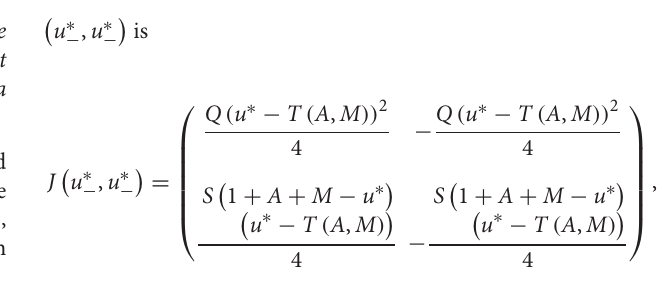
FIGURE 6 | Phase plane of system (4) for A 0.1, M 0.1 and Q 0.363 for varying S . The equilibria (0,0), (1,0) and P 2 are always saddles. The brown (red) = = − = curve represents the predator (prey) nullcline. (A) For S 0.3 both P 1 and P 3 are attractors. The stable manifold of P 2 ( W s ) forms a separatrix between the basin of = ( 1,0 ) connects to P 3 . (B) For S attraction of P 1 (orange region) and the basin of attraction of P 3 (grey region) and W u 0.24962827 both P 1 and P 3 are still attractors = տ ( 1,0 ) forming a heteroclinic and the stable manifold of P 2 still forms a separatrix between the two basins of attraction. However, the separatrix now connects to W u տ curve between P 2 and (1,0). (C) For S 0.235 both P 1 and P 3 are attractors. The stable manifold of P 2 forms a separatrix between the basin of attraction of P 1 = ( 1,0 ) connects to P 1 . (D) For S ( P 2 ) connects to (0,0) and W u 0.225 both P 1 and P 3 are (orange region) and the basin of attraction of P 3 (grey region). Here, W s = տ ր ( 1,0 ) connects to P 1 . still attractors and P 3 is surrounded by an unstable limit cycle. This limit cycle forms a separatrix between the two basins of attraction. Here, W u տ ( 1,0 ) now connects to P 1 . (F) For S (E) For S 0.18 the equilibria P 3 is a repeller and P 1 is a global attractor. Hence, also W u 0.13 both P 1 and P 3 are repellers = = տ ( 1,0 ) connects to a stable limit cycle which surrounds the three positive and W u տ